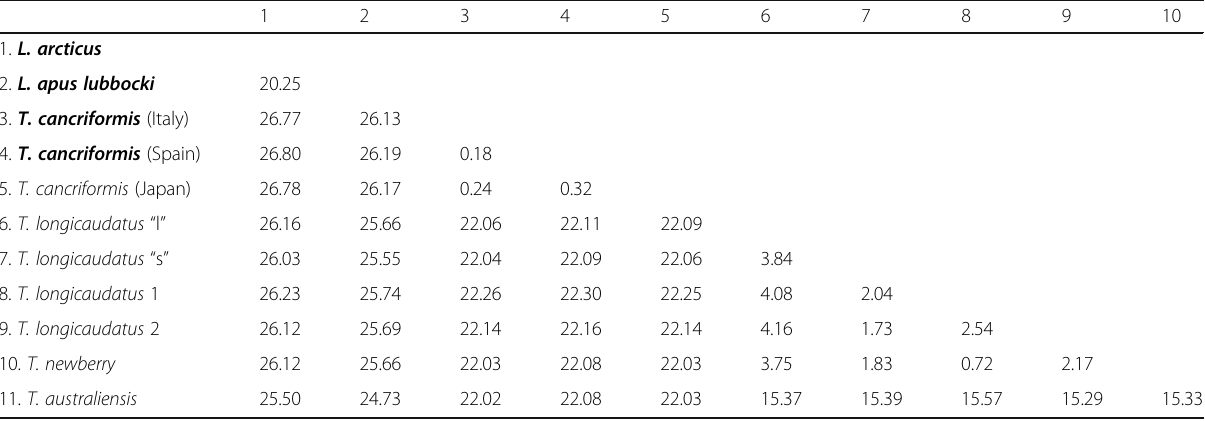
Table 3 Sequence divergence (%) between Notostraca taxa based on PCG and rRNA gene sequences. Species with newly sequenced mitogenomes are marked in bold